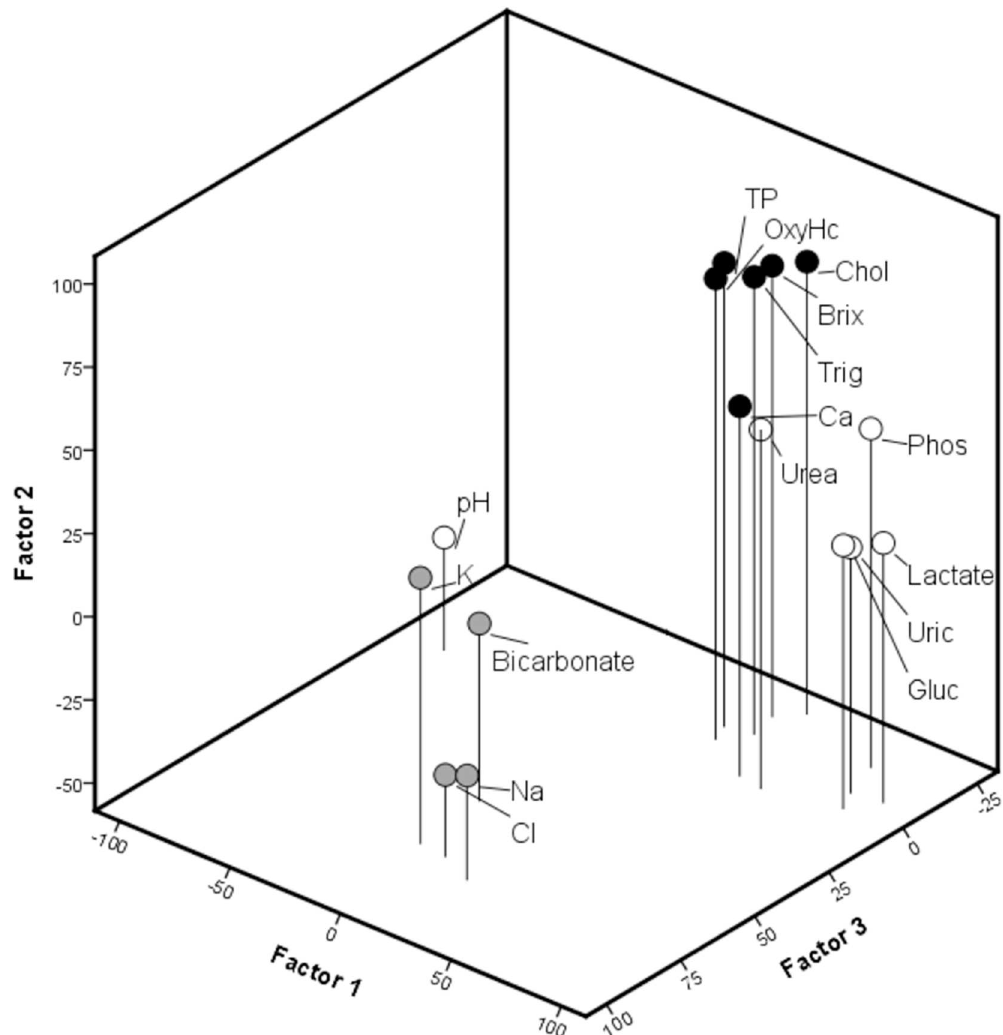
Fig 4. Rotated factor loadings for haemolymph biochemistry data. Factor 1: white circles; factor 2: black circles; factor 3: grey circles.